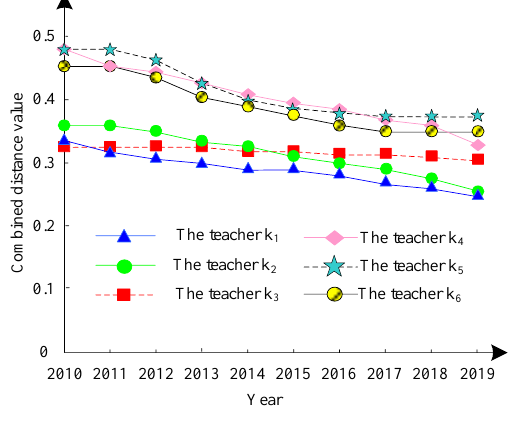
Figure 2. Change of comprehensive distance values of teachers from 2010 to